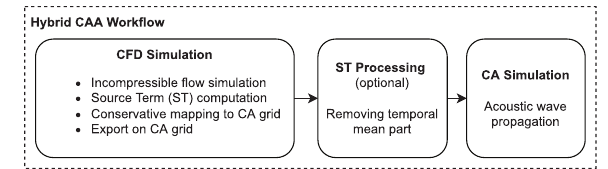
Figure 1. CAA simulation work fl ow applied in the hybrid